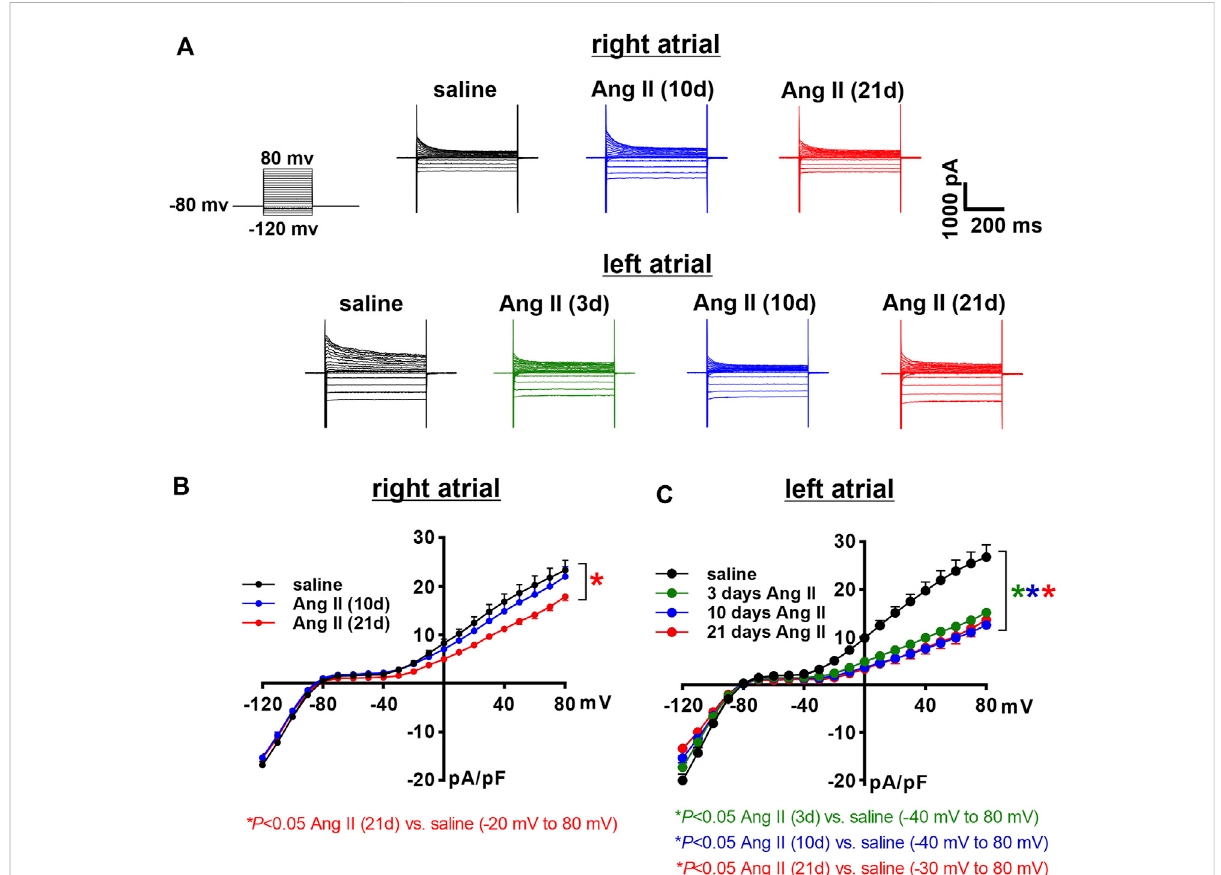
FIGURE 7 Time course of the effects of Ang II on total right and left atrial potassium currents. (A) Representative total I K recordings in right and left atrial myocytes isolated from mice infused with saline for 21 days or Ang II for 3, 10 and 21 days. Voltage clamp protocol shown beside recordings. (B) Summary I K IV curves measured at the peak of the I K recordings for right atrial myocytes isolated from mice infused with saline or Ang II for 10 and 21 days.* p < 0.05vssaline, + p < 0.05vsAngII(10 days)bytwo-wayrepeatedmeasuresANOVAwithaHolm-Sidakposthoctest. (C) SummaryI K IV curves measured at the peak of the I K recordings for left atrial myocytes isolated from mice infused with saline or Ang II for 3, 10 and 21 days. * p < 0.05 vs saline at indicated membrane potentials by two-way repeated measures ANOVA with a Holm-Sidak posthoc test. For right atrial